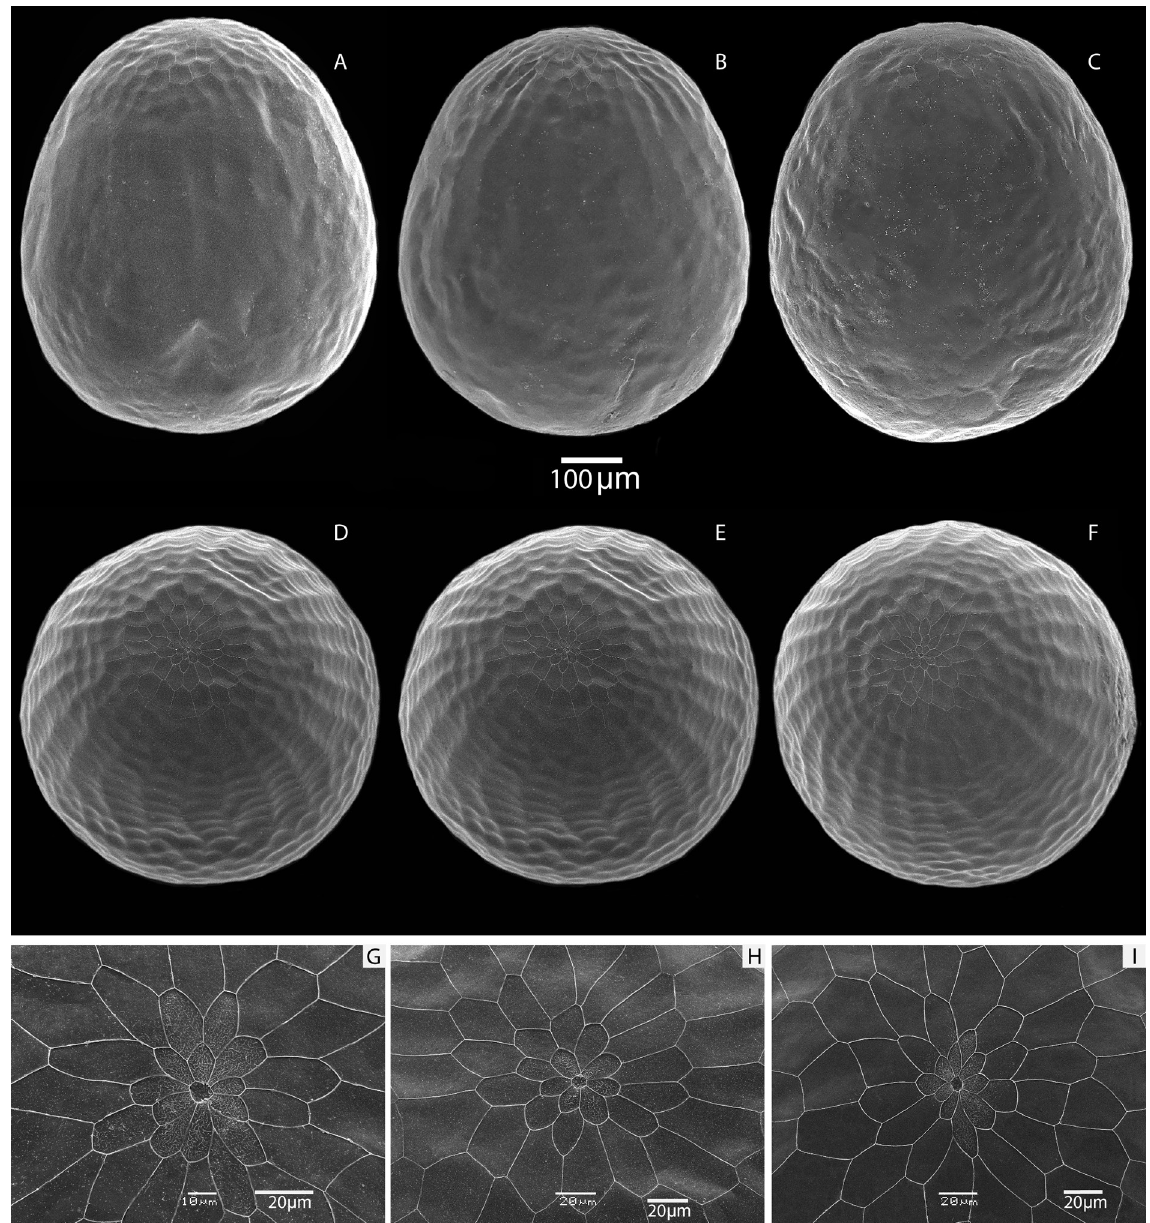
Fig. 12. Eggs of Melitaea timandra timandra Coutsis & van Oorschot, 2014, S. Turkmenistan, Sary- Yazy. A–C . Lateral view. D–F . View from above. G–I . Micropile